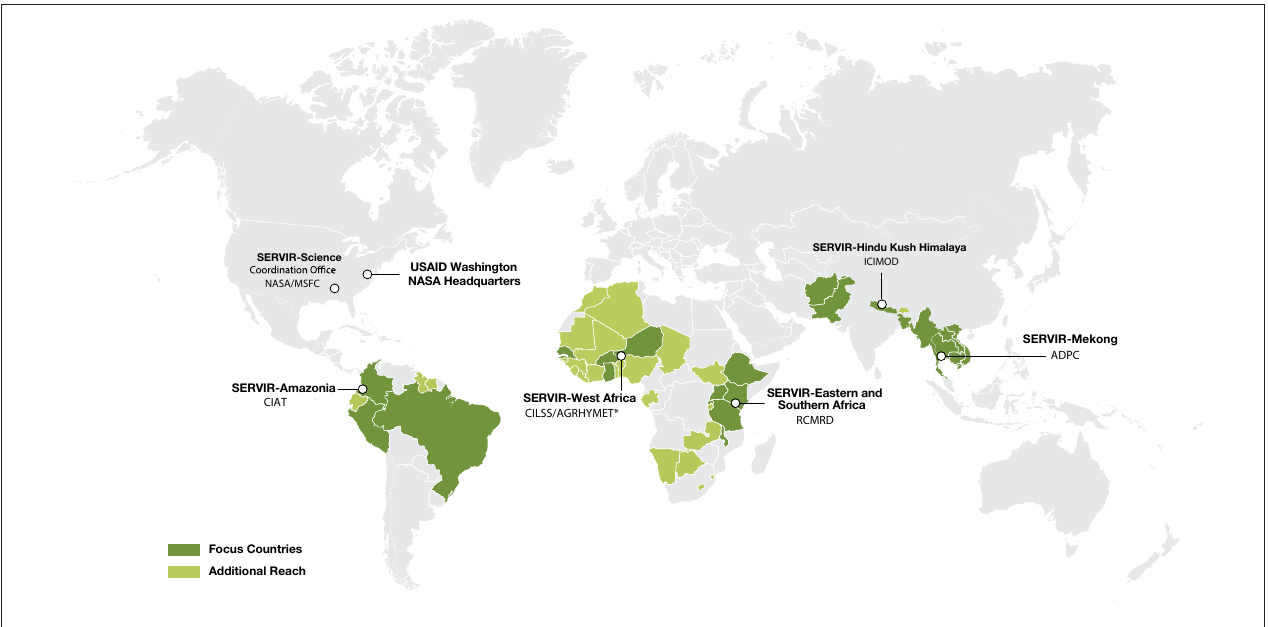
FIGURE 1 | Geographic regions and primary countries served by the five SERVIR regional